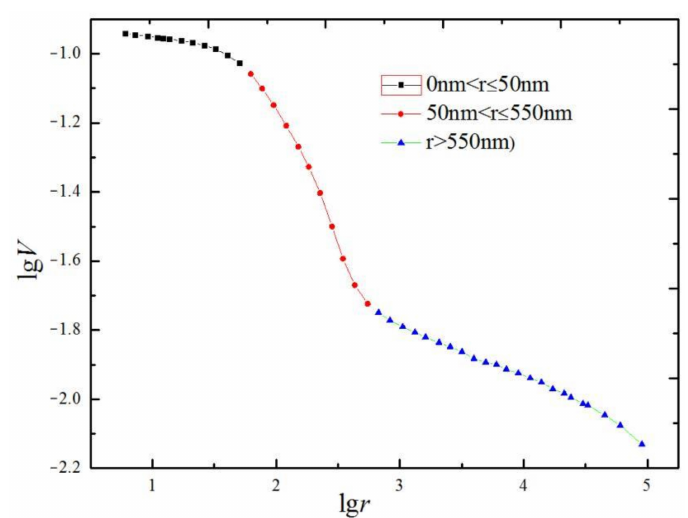
Figure 9. Relationship between Lg r and Lg V of comparing concrete.